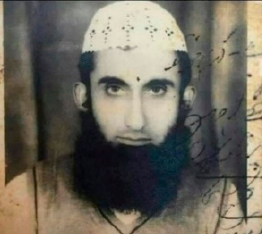
Figure 2. Maulana Tariq Jamil as a young relatively unknown religious scholar. Source: https: